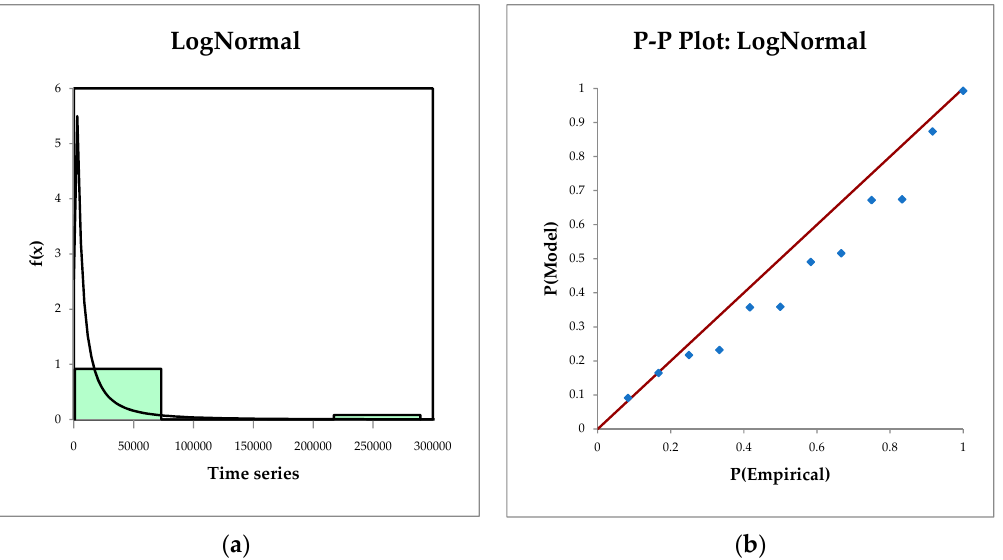
Figure 2. Monthly tweets between October 2015 and September 2016: ( a ) lognormal distribution curve and ( b ) lognormal P-P plot.